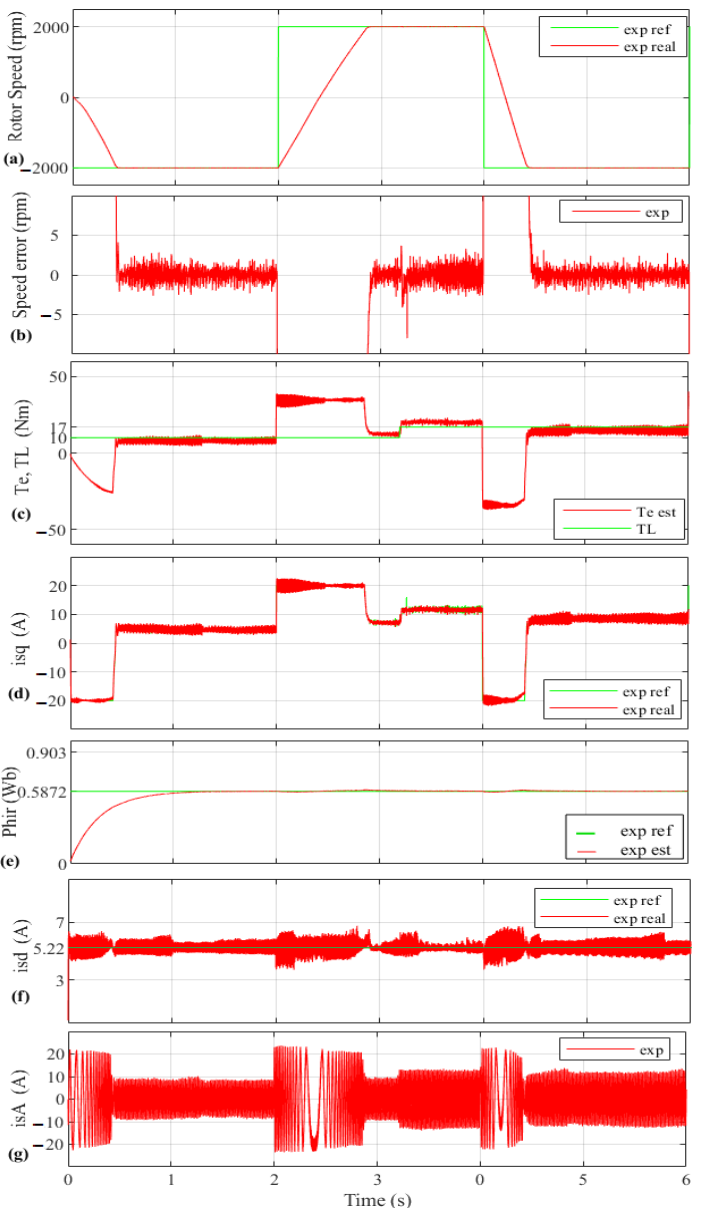
Figure 10. Experimental results using 2000-rpm reference speed and two load torque step changes (enhanced ISMC D2 design): ( a ) Rotor speed, ( b ) Speed error, ( c ) T e , T L , ( d ) Torque current, ( e ) Rotor flux, ( f ) Rotor flux current and ( g ) Stator